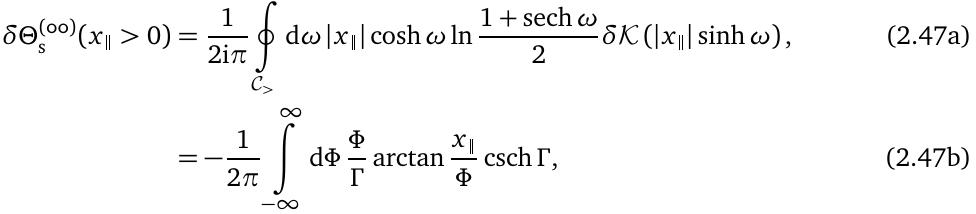
Figure 7: Scaling function Σ ρ ≤ 1. With shrinking aspect ratio ρ the influence of the domain wall vanishes and becomes zero in the limit of thin